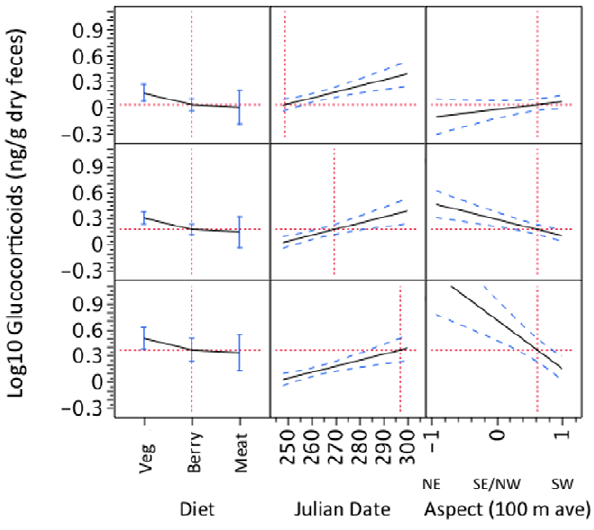
Figure 3. Effect of diet, Julian date, and aspect on glucocor- ticoid concentrations in time 0 bear scats collected in Glacier National Park, Montana. Each row reflects a different Julian date, 20 days apart, as indicated by the dashed vertical line in the center column of each row. Aspect is transformed, whereby 2 1= coolest and + 1= warmest aspect (see